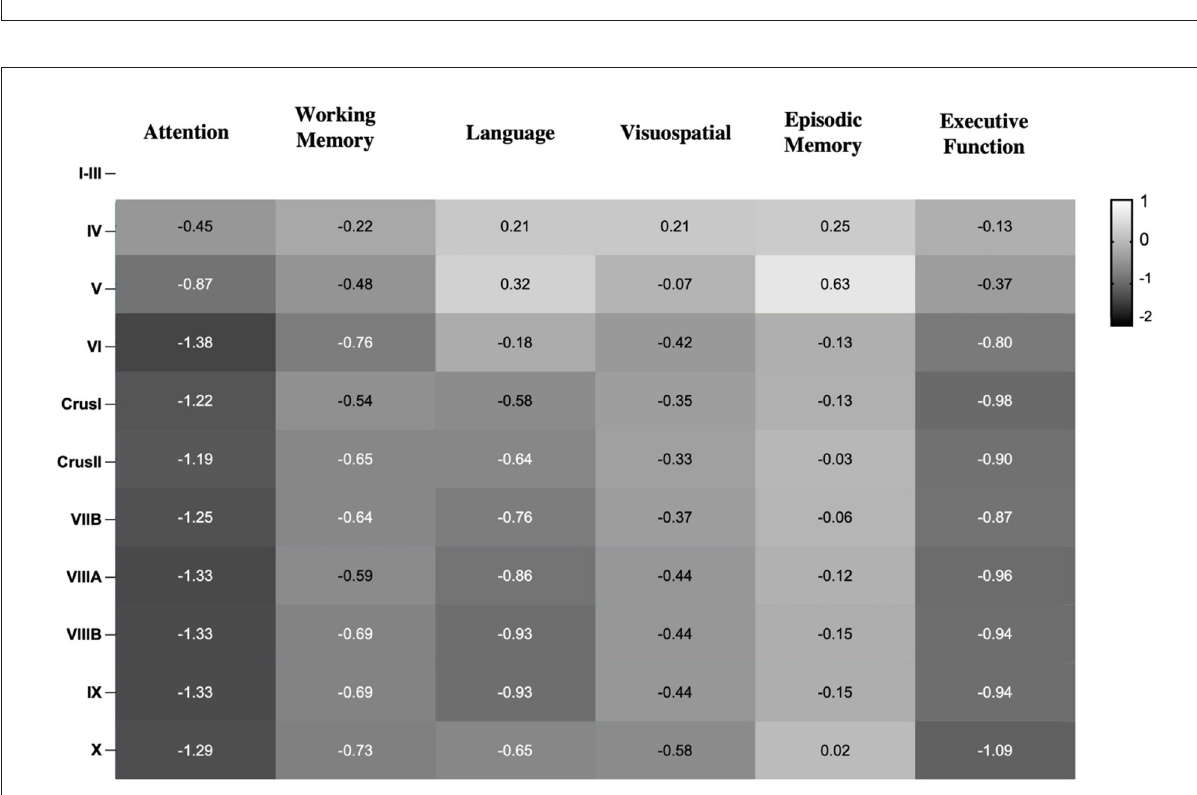
FIGURE4 Hot spot figure of z -transformed scores of different cognitive domain, grouped according to lobular lesion topography.